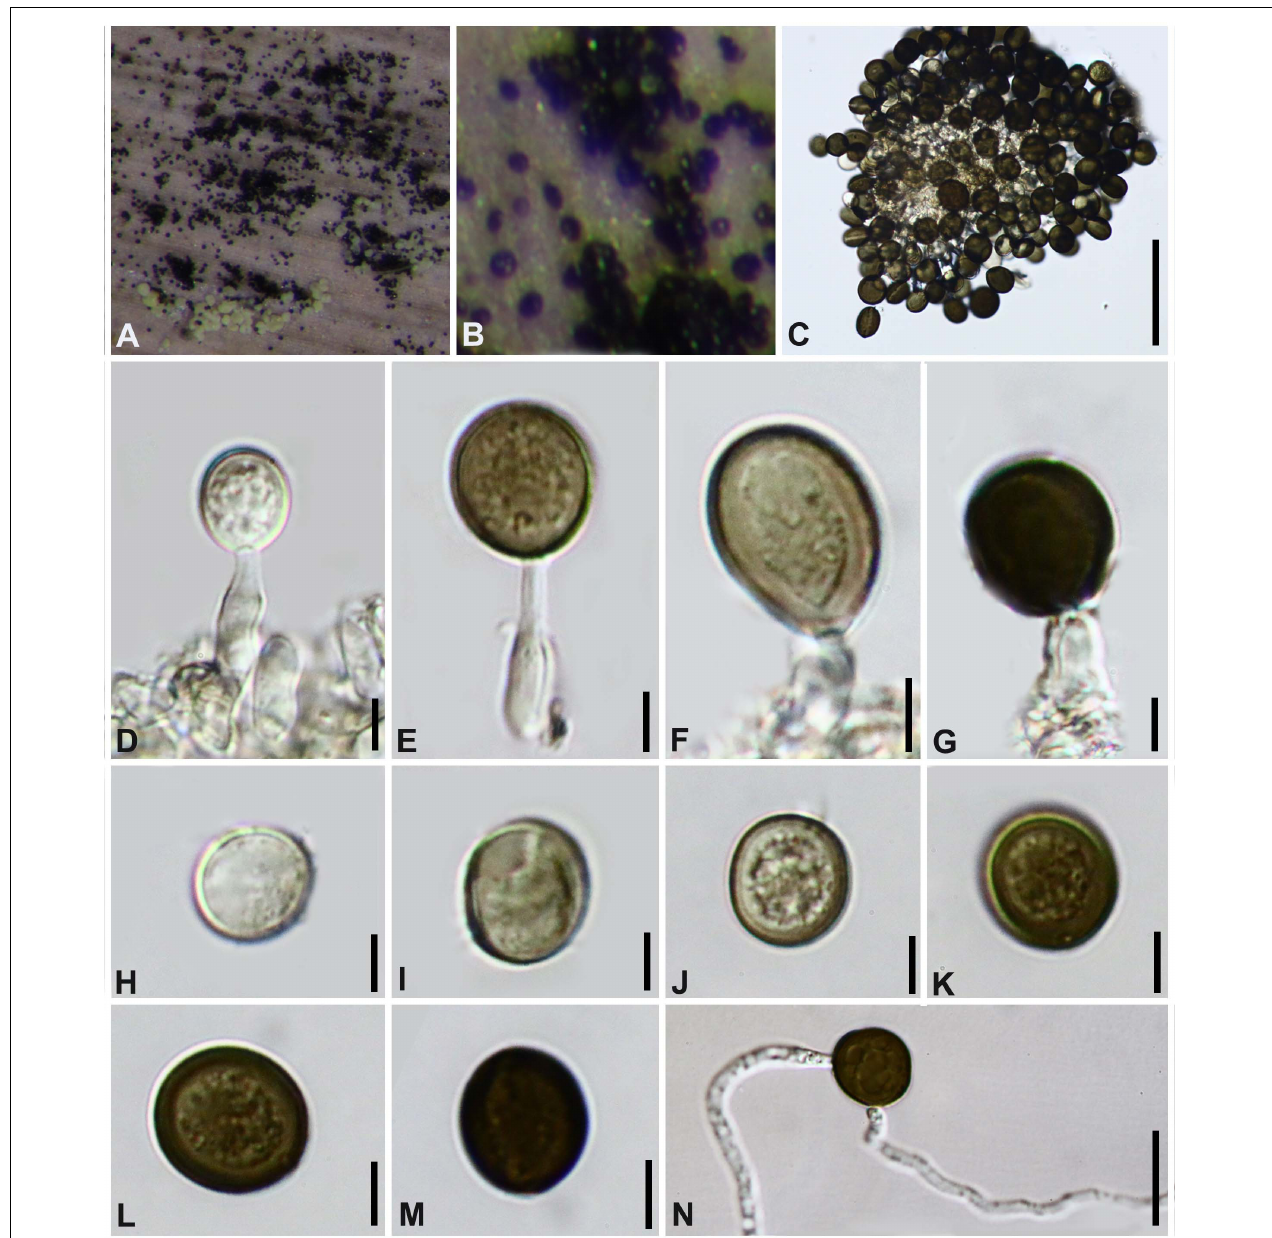
FIGURE 11 | Arthrinium hydei (GZAAS 20–0098) (A , B) Colonies on substrate. (C–F) Conidiogenous cells and conidia. (G–M) Conidia. (N) Germinating conidia. Scale bars: (C) = 50 µ m. (D–M) = 5 µ m. (N) = 25 µ m.